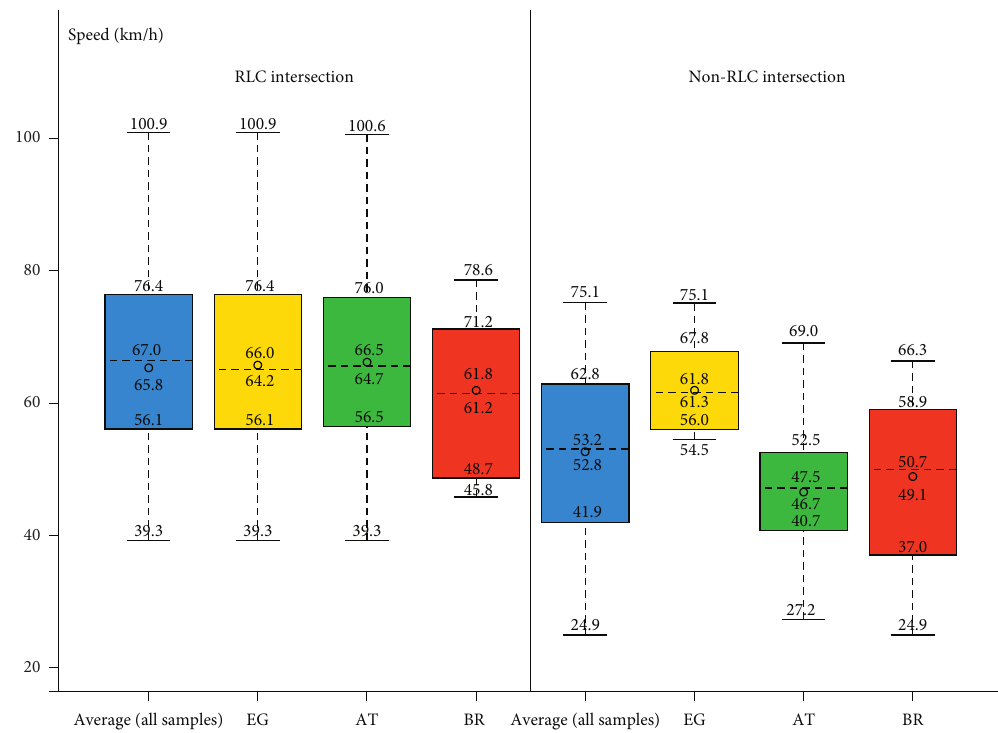
Figure 3: Statistical features of speed in different